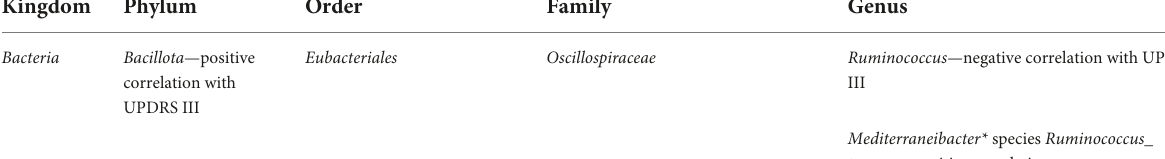
TABLE 3 Relative abundances of bacterial taxa in correlation with motor